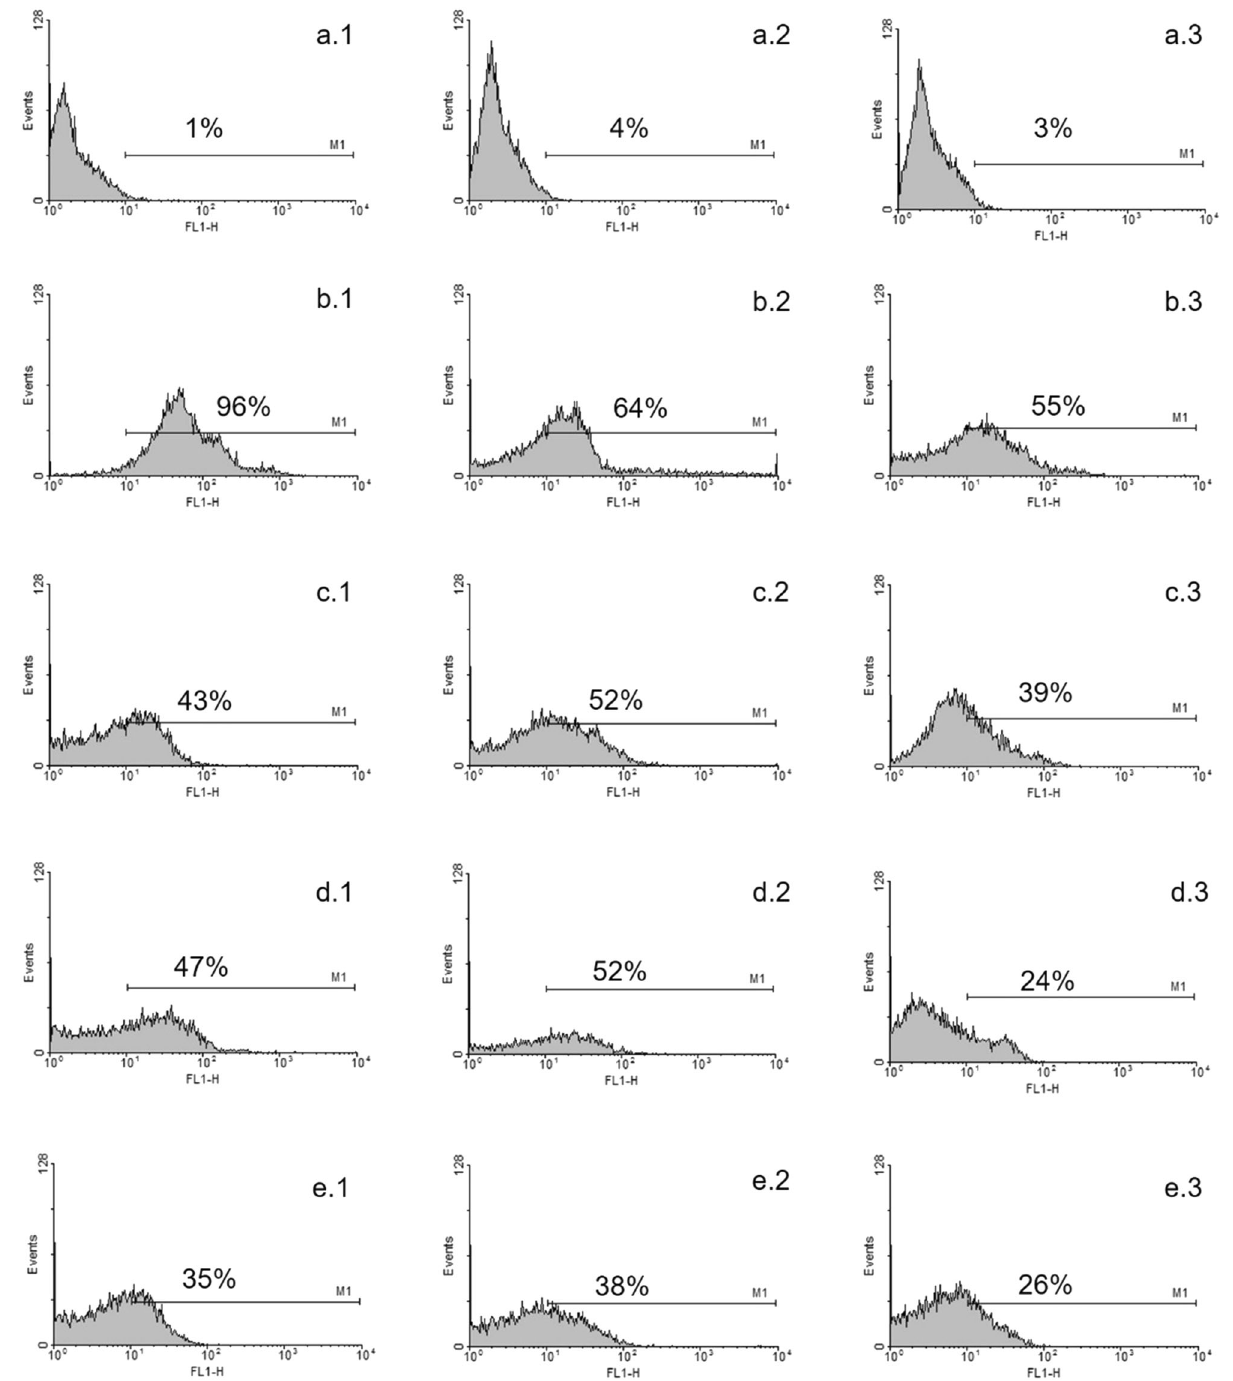
Fig. 1 Histogram obtained by fl ow cytometry. a Control group with no implant ( a.1 ) 7, ( a.2 ) 15, and ( a.3 ) 30 days after implantation. b Stainless-steel implants after ( b.1 ) 7, ( b.2 ) 15, and ( b.3 ) 30 days. c DLC coated implants after ( c.1 ) 7, ( c.2 ) 15, and ( c.3 ) 30 days. d TiO 2 -